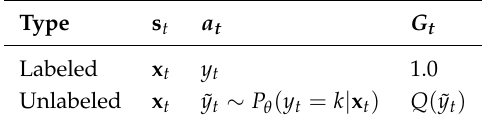
Table 1. Semi-supervised learning from the aspect of policy gradient.